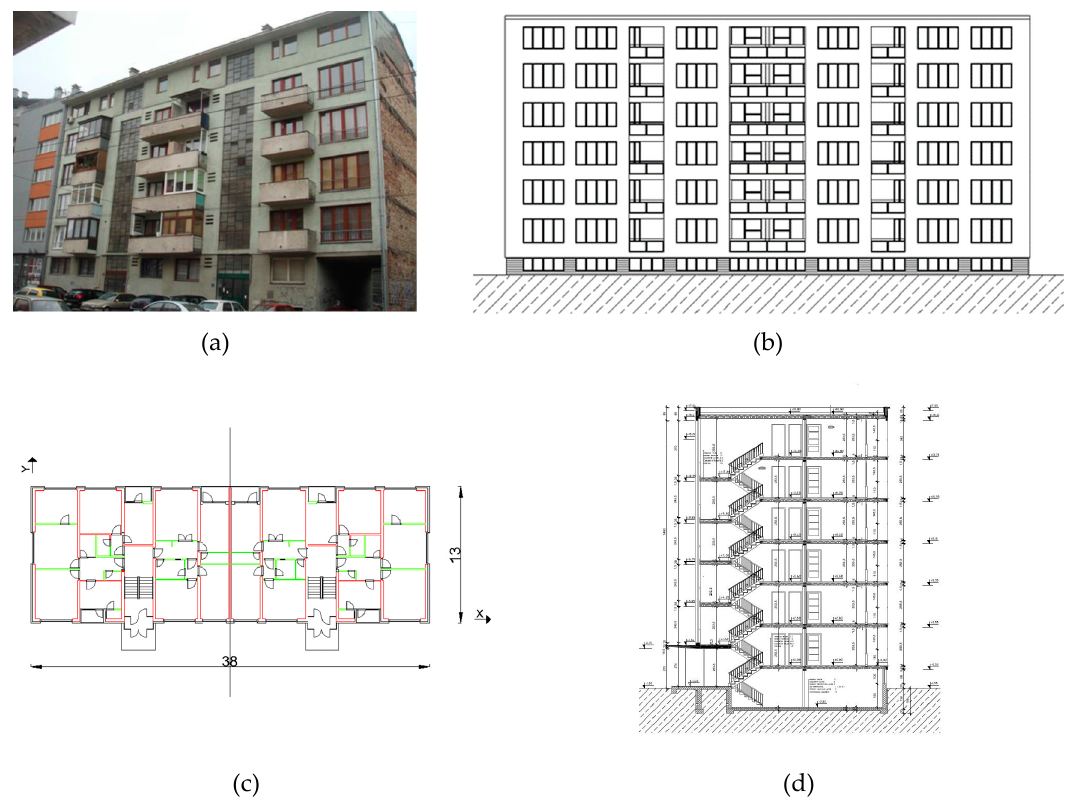
Figure 3. ( a ) Analyzed building located in Sarajevo; ( b ) east façade; ( c ) plan view of the typical floor and labeling of coordinates (X and Y); ( d ) typical cross section.